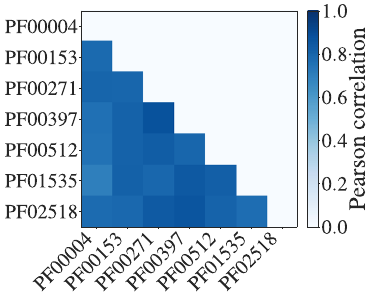
Fig. 3 | Pearson correlations between regression coef fi cients in larger MSAs. Suf fi ciently deep ( ≥ 100 sequences) and long ( ≥ 30 residues) MSAs are considered (mean/min/max Pearson correlations: 0.80/0.69/0.87).